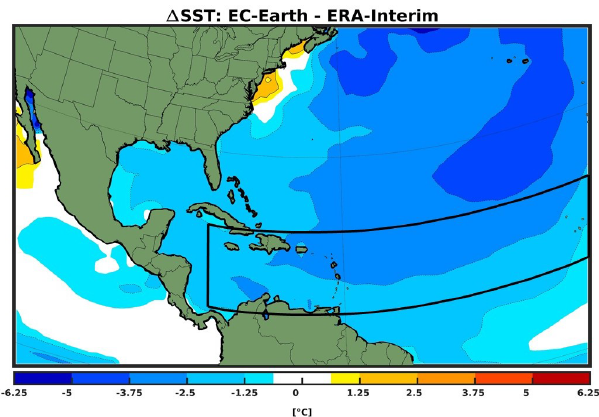
Figure A3. Climatological changes in SST between simulated EC-Earth pre-industrial climate and ERA-Interim reanalysis from 1979 to 2008. The black box shows the approximate present-day MDR. The contour lines follow the color-bar scale (dashed, negative anomalies; solid, positive anomalies); the 0 line is omitted for clarity.